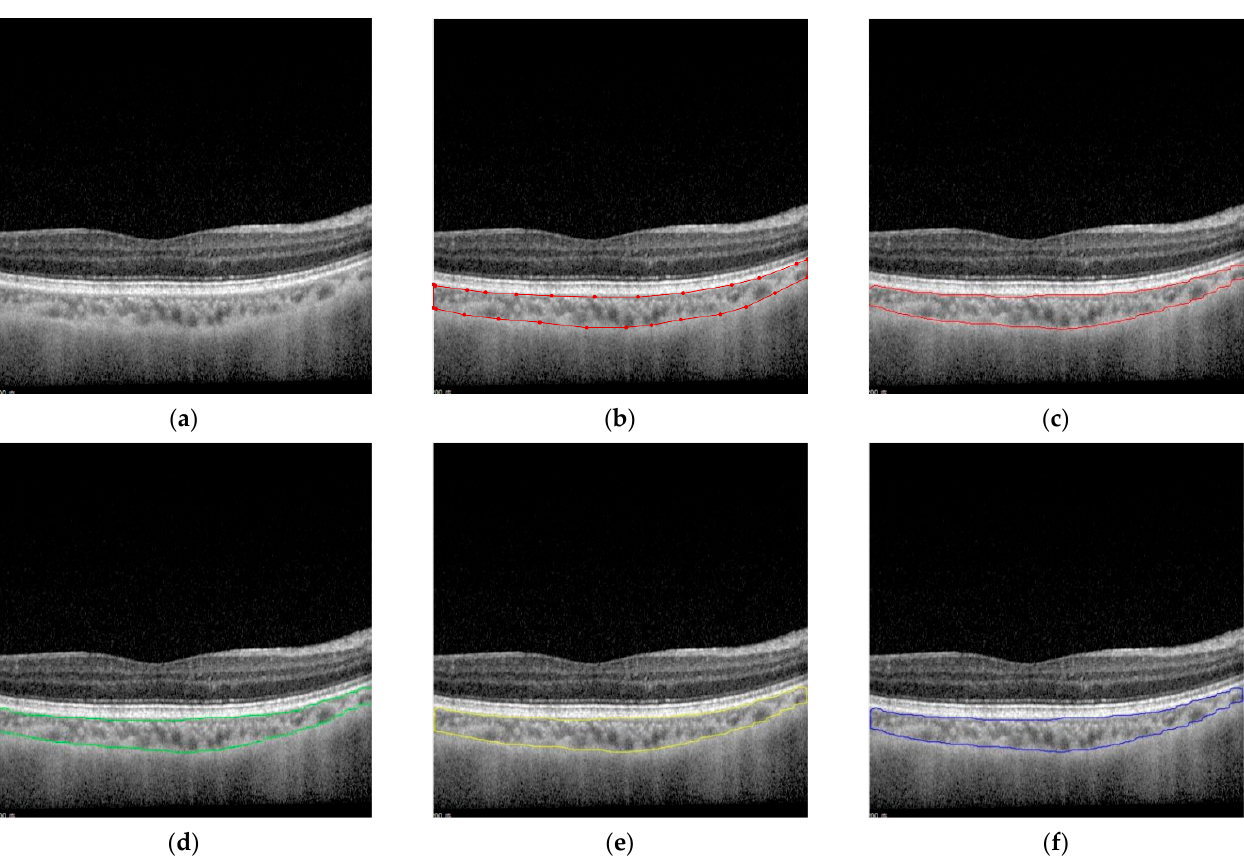
Figure 8. Sketching result of case 2: ( a ) original image, ( b ) doctor’s drawing, ( c ) R50 model, ( d ) R101 model, ( e ) AND model and, ( f ) OR model.